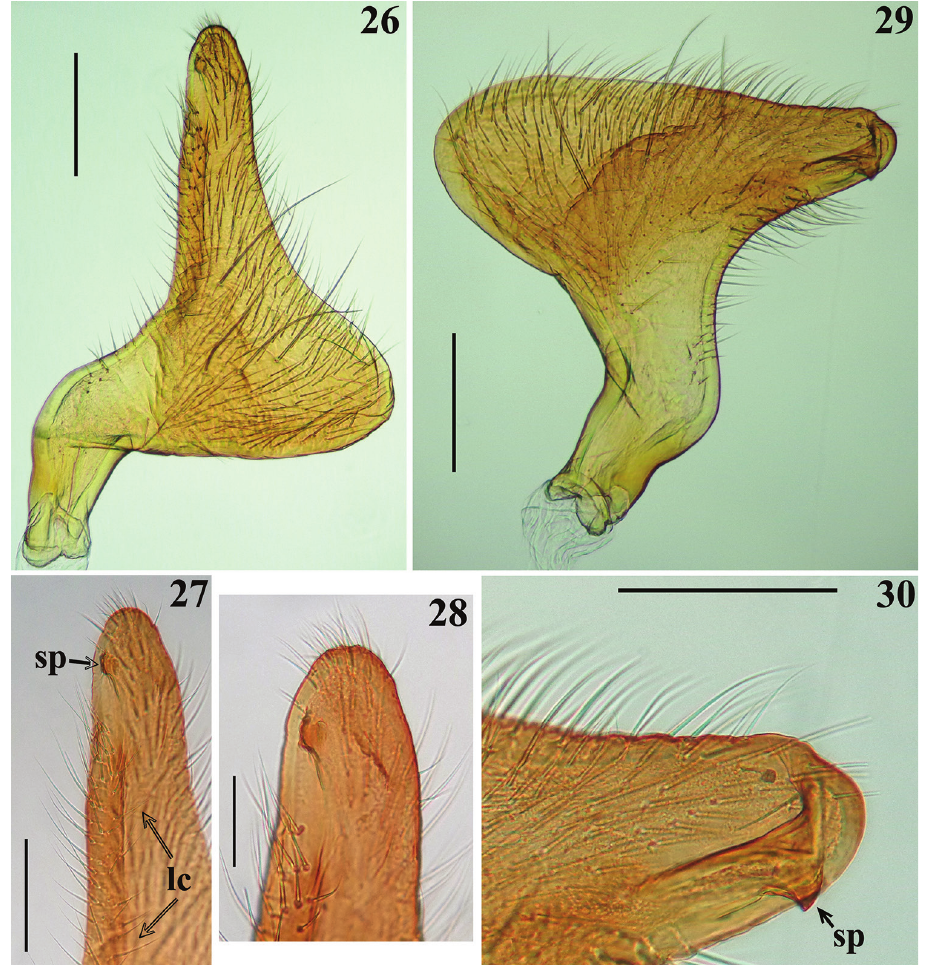
Figures 26–30. Zeraikia zeraikae sp. n., male genitalia, parameres. 26–28 left paramere 27–28 apical portion 29–30 right paramere 30 apical portion. ( sp subapical process; lc longitudinal crest). Scale bars: 0.3 mm ( 26, 29 ); 0.2 mm ( 27, 30 ); 0.1 mm ( 28 ). ly only to a third of distance between dorsal and ventral surfaces; faintly sclerotized; left (in dorsal view) flat lateral expansion ( fle ) approximately a third larger than right flat lateral expansion; apical third of dorsal phallothecal sclerite slightly curved in lateral view. Subapical tubular projection of endosoma wall ( stp ) conspicuously enlarged at apical portion, which is subtriangular in shape, with several low rugose crests and a very thin elongated appendix ( app ) at its tip, which is rounded (Figs 34, 37–38); inside its basal portion, an elongated, thin, slightly curved process ( ep ) formed by numerous, small, subtriangular to spined, somewhat sclerotized elements (Figs 34–35). An addi- tional very small, rounded, somewhat sclerotized, subapical process ( ssa ) present just ventral to basal portion of the elongated curved apical process ( ap ) (Figs 31, 34,